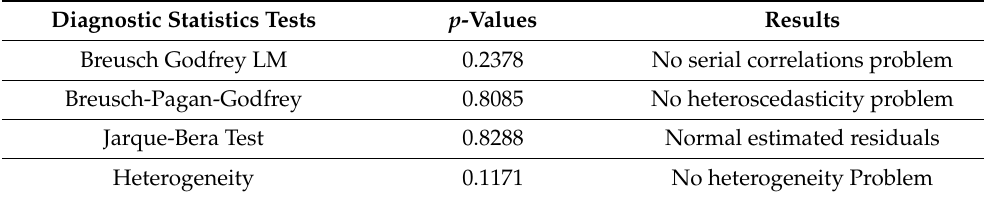
Table 8. Diagnostic statistics tests.